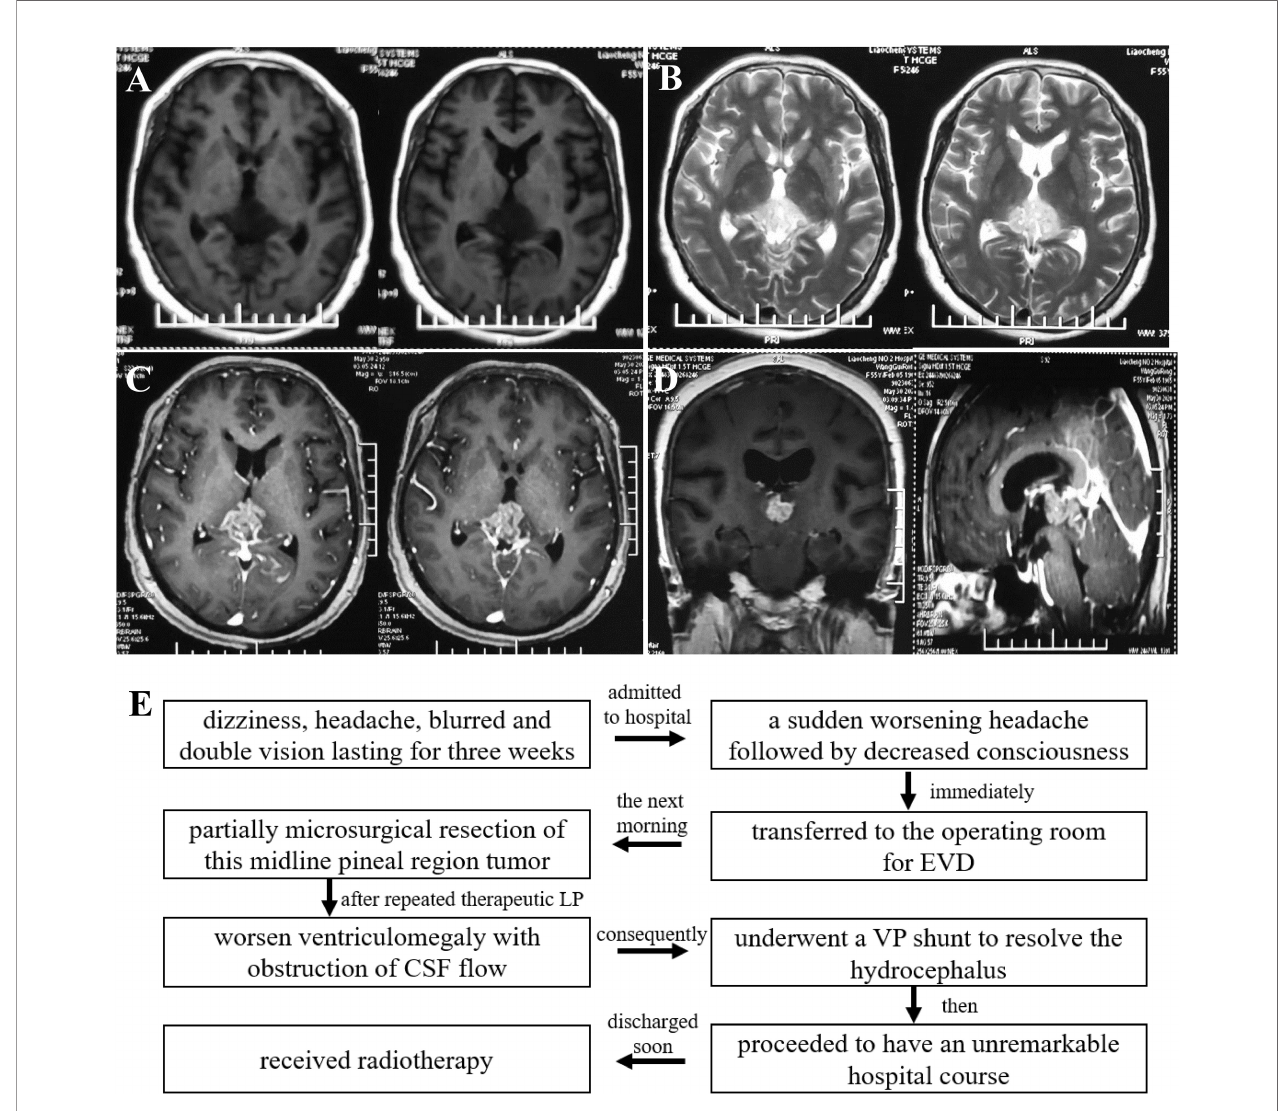
FIGURE 1 | Pre-operative T2-weighted (A) , T2-FLAIR weighted (B) , and enhanced axial, coronal, sagittal T1-weighted (C, D) magnetic resonance images showed a heterogeneously enhancing solid mass in pineal gland region, extending into the bilateral thalamus and obliterating the third ventricle, with ventriculomegaly. A fl ow chart showcased the timeline with relevant data from the episode of care (E)